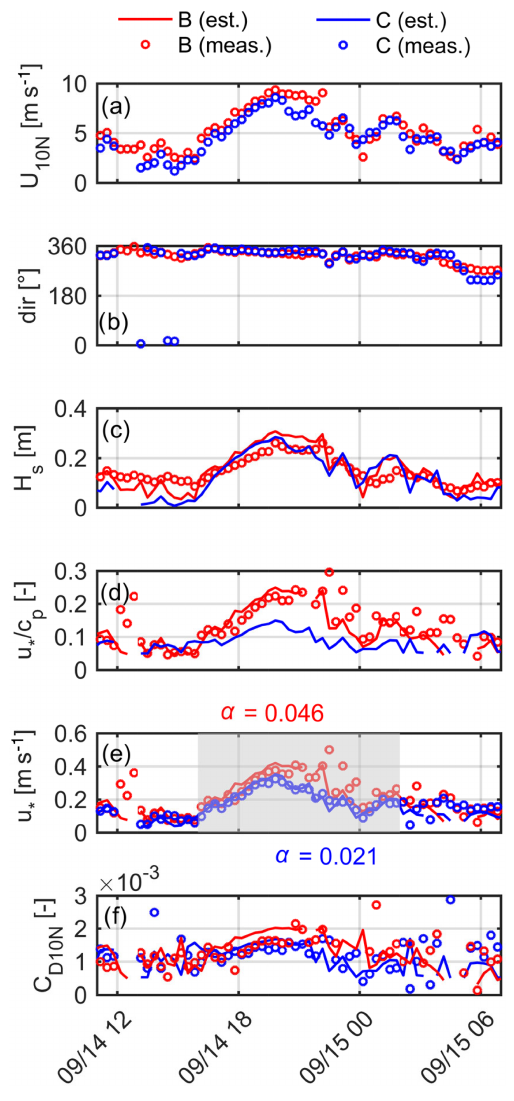
Figure 9. Time series of (a) wind speed, (b) wind direction, (c) sig- nificant wave height, (d) wave age, (e) friction velocity and (f) drag coefficient for the selected wind event. Red colour represents sta- tion B, while blue colour represents station C. Observations are plotted with circles, model calculations with continuous